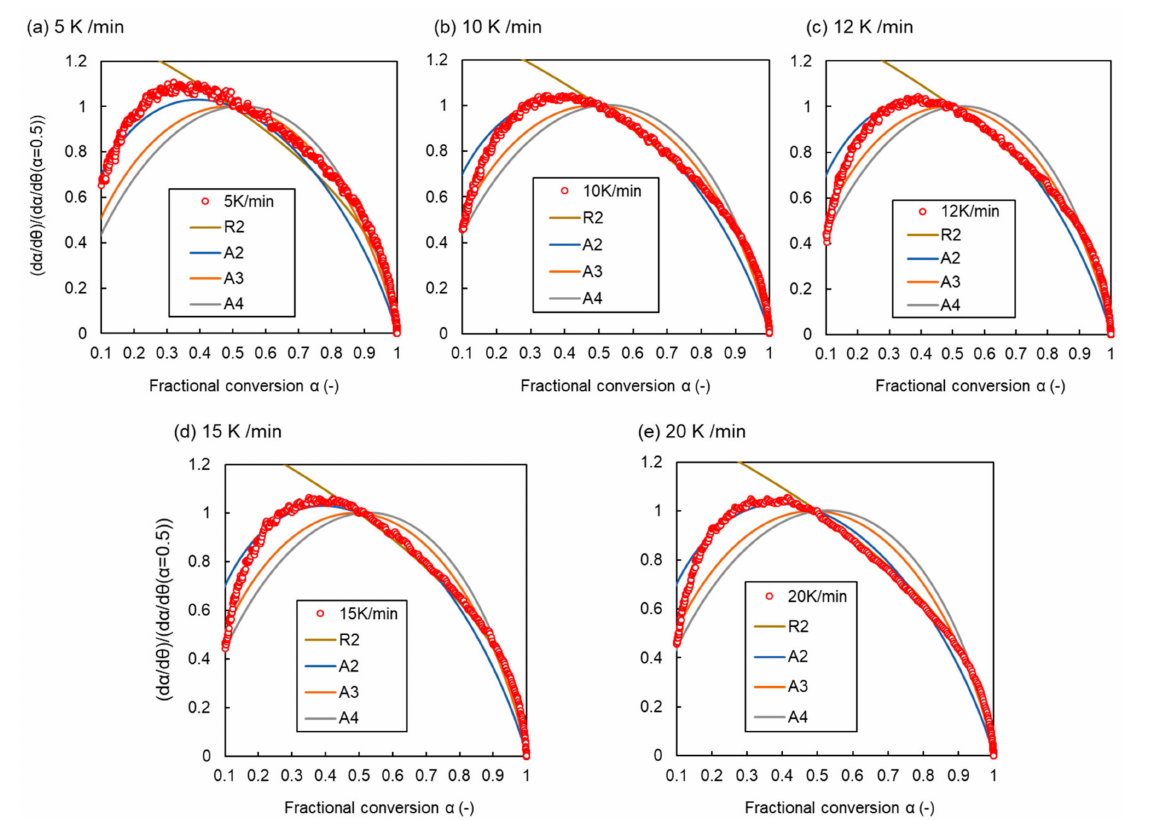
Figure 5. Master plots of the long-term cycled sample during the HC mode at heating rates of ( a ) 5 K/min, ( b ) 10 K/min, ( c ) 12 K/min, ( d ) 15 K/min, and ( e ) 20 K/min. Comparison of the experimental kinetic data (red circles) for the long-term cycled sample and possible reaction model (curves) against variations in the fractional conversion of α